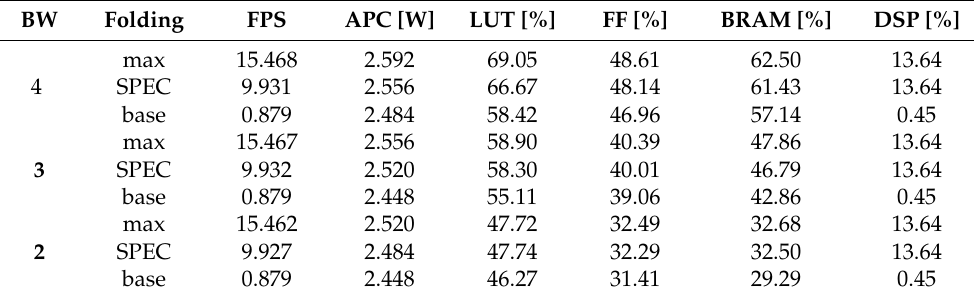
Figure 11. Dependence of model ACC on inverse FPR value (100% ≡ 0% FPR) using L8-D dataset excluding Snow/Ice biome. Optimal solutions are highlighted by Pareto fronts. Table 7. FPGA resource utilization and performance for different model bit widths and folding setup.